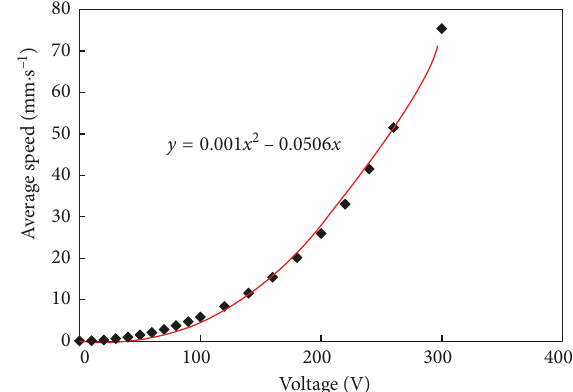
Figure 8: Relation between average velocity of single outlet and applied electric field strength.